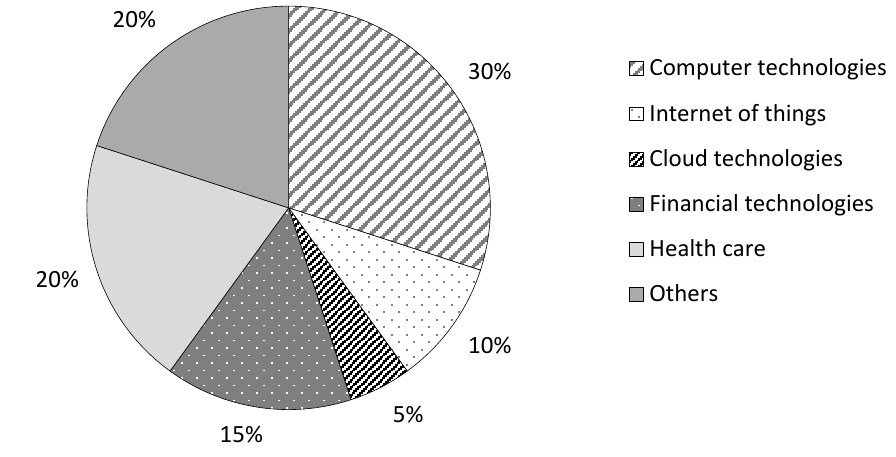
Figure 5. Areas of surveyed small innovative business